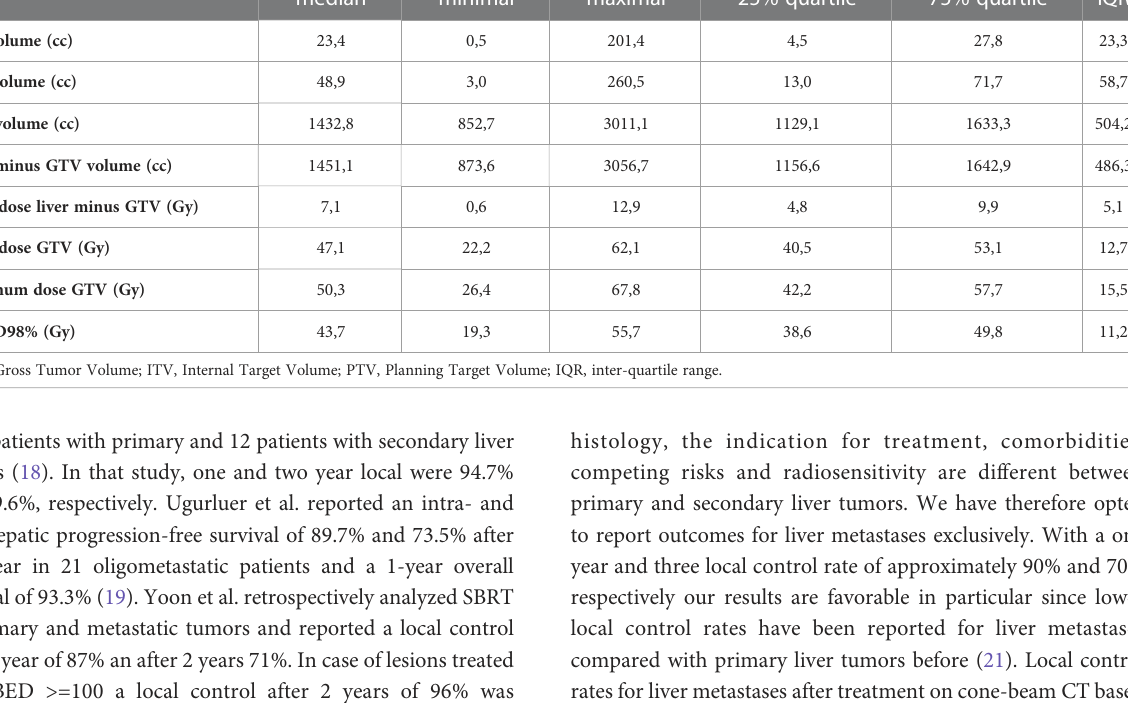
TABLE 2 Dosimetric parameters. GTV-Gross tumor volume, IQR-Inter quartile range. median